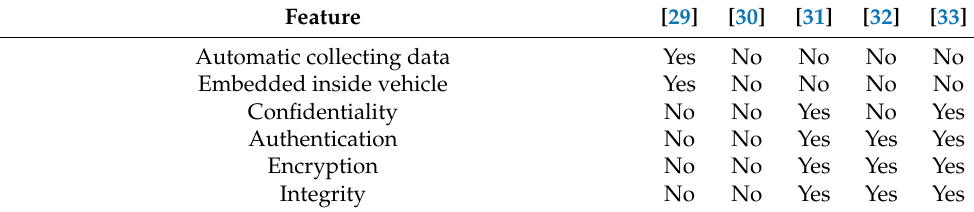
Table 2. Feature comparison of existing